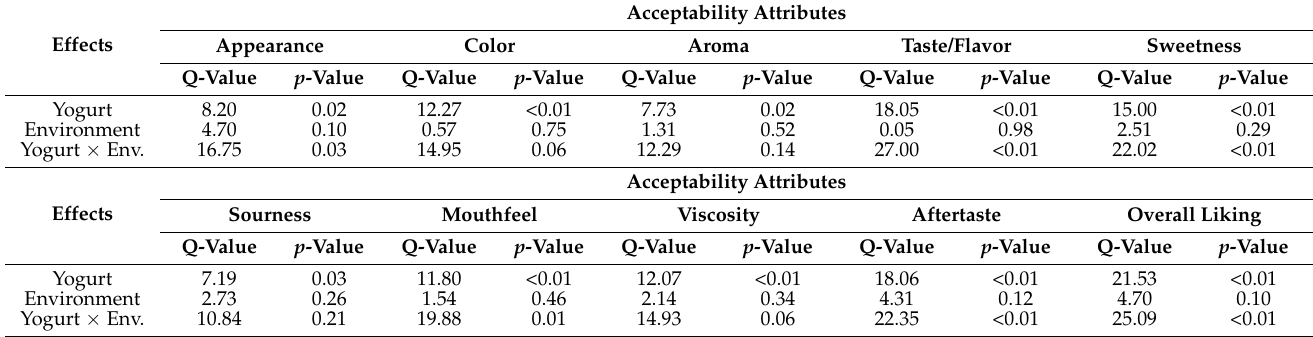
Table 1. The Q- and p -values summary ( α = 0.05) of the Friedman analysis from the sensory attributes on yogurt samples under different